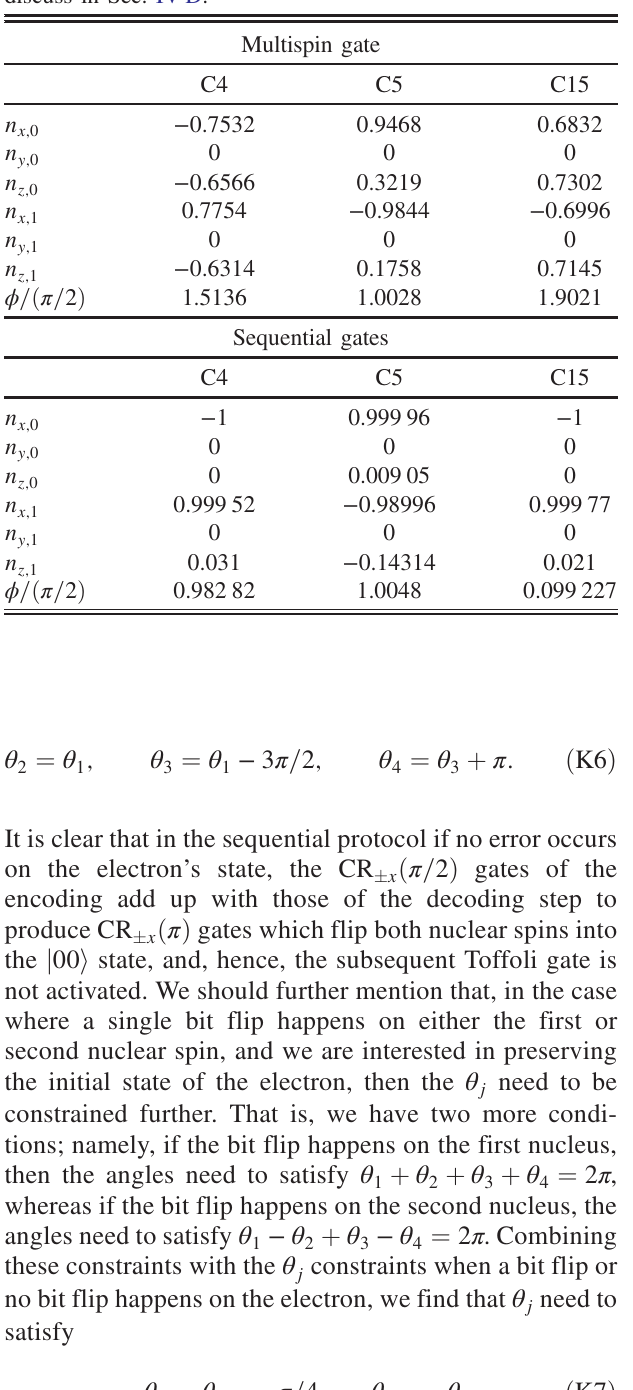
TABLE XI. Nuclear rotation axes and rotation angles for the multispin operation (case 23, k ¼ 3 ) and the sequential gates we discuss in Sec. IV